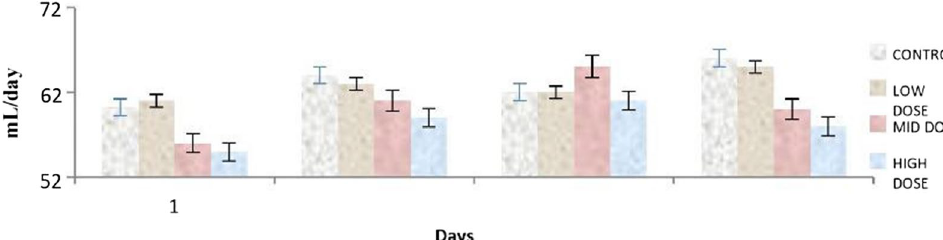
Fig. 6 Changes of Wistar albino rat’s water intake (mL/day) exposed to TRV